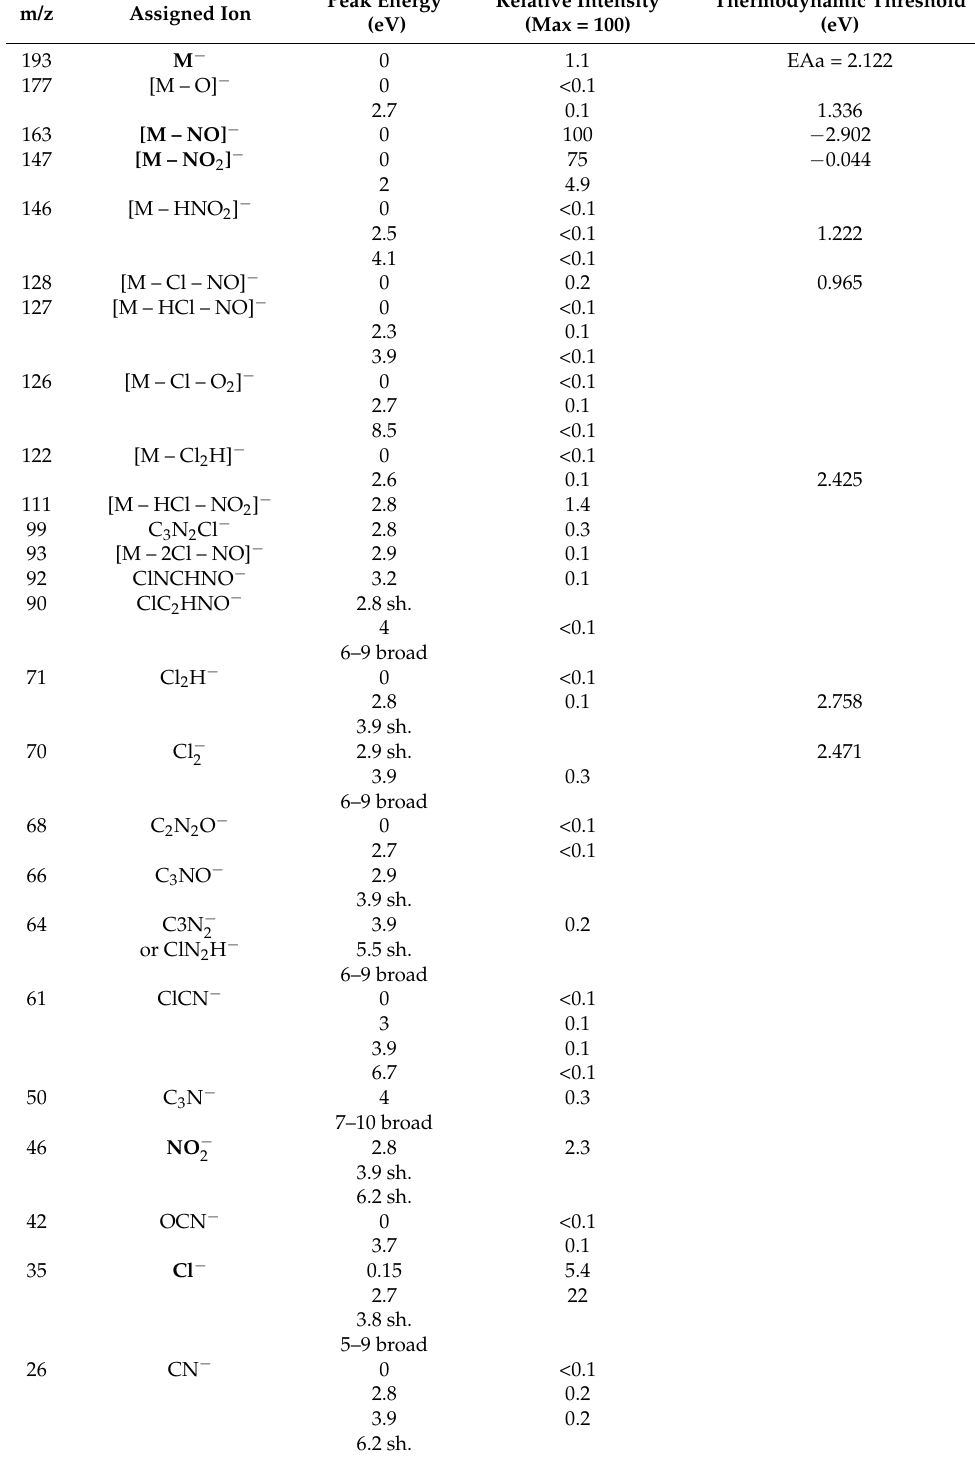
Table 1. Assigned structures of fragment negative ions observed in DEA spectra, peak energies (eV) and relative intensities evaluated from the peak heights as obtained using the electron attachment spectrometer with sector mass analyzer. Thermodynamic thresholds for individual reaction channels are taken from DFT B3LYP/6-31G+(d) calculations in Gaussian